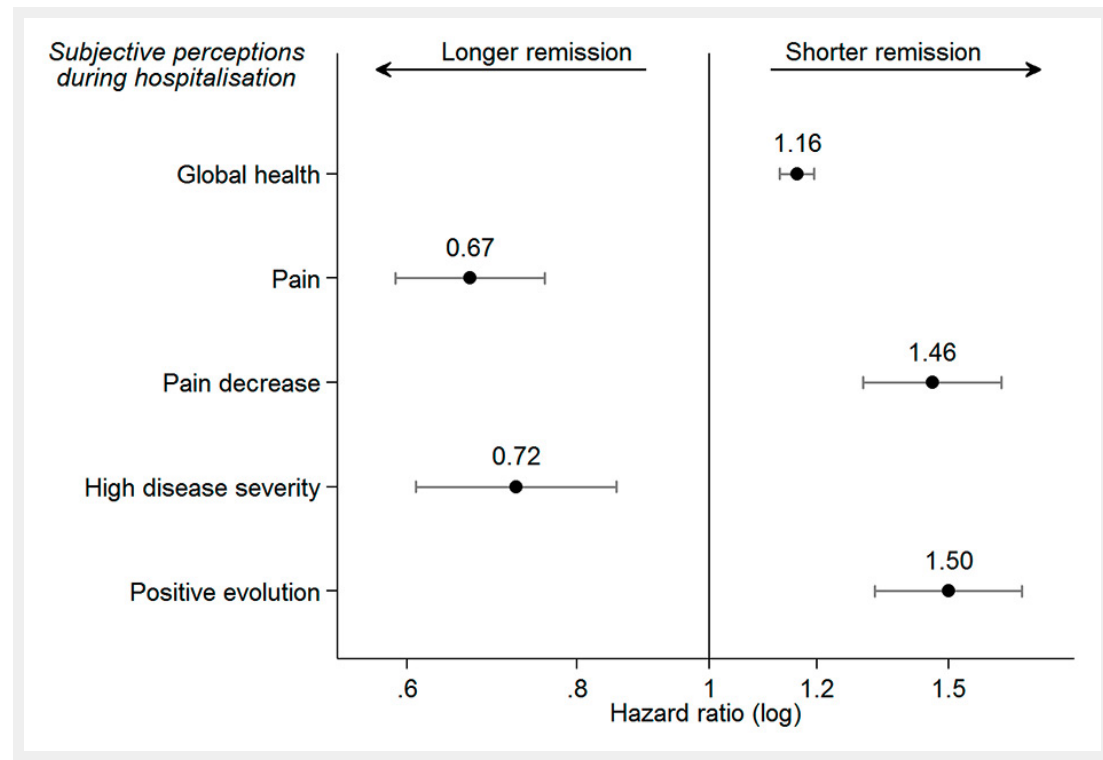
Figure 2 Hazard ratios (HRs) for the final model (n = 807). For health, pain and pain evolution, the HR refers to increments of two standard deviations. An HR above 1 shows an increased probability to be considered fit for work.